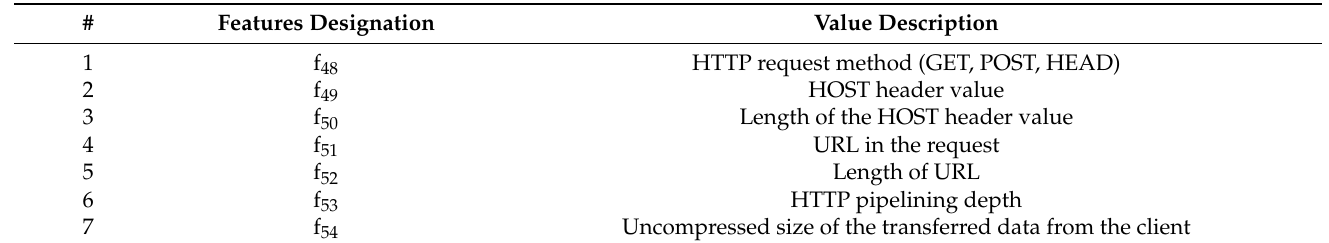
Table 4. HTTP-based